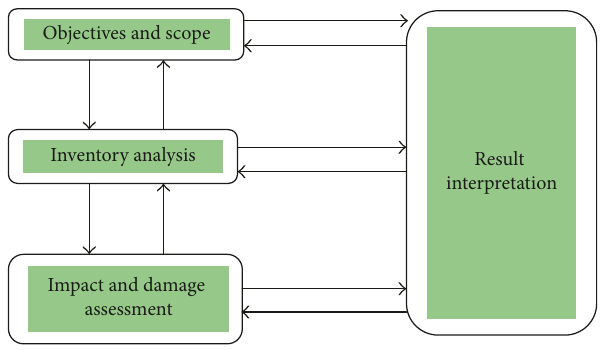
Figure 1: Framework for carbon footprint